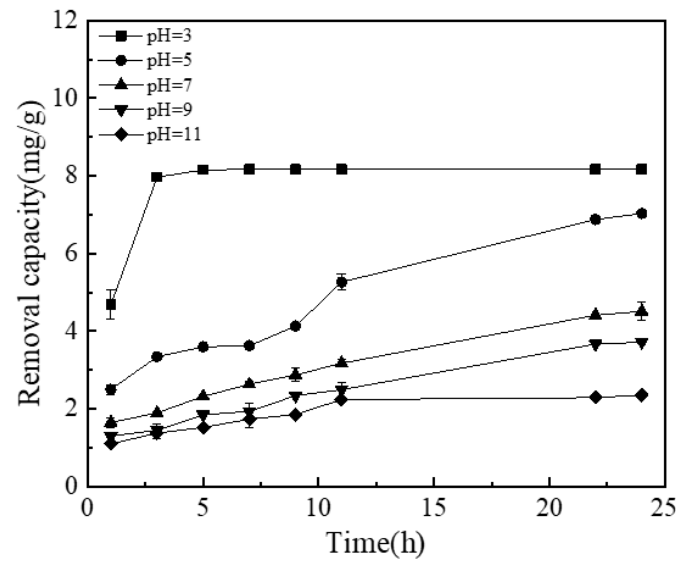
Figure 8. Effect of pH on TP removal effect (the dosage is 5 g/L; initial phosphorus concentration is 50 mg/L).